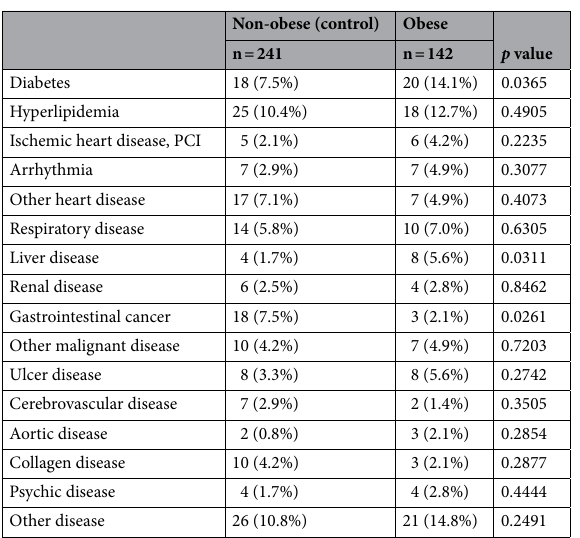
Table 4. Preoperative complication. PCI, percutaneous coronary